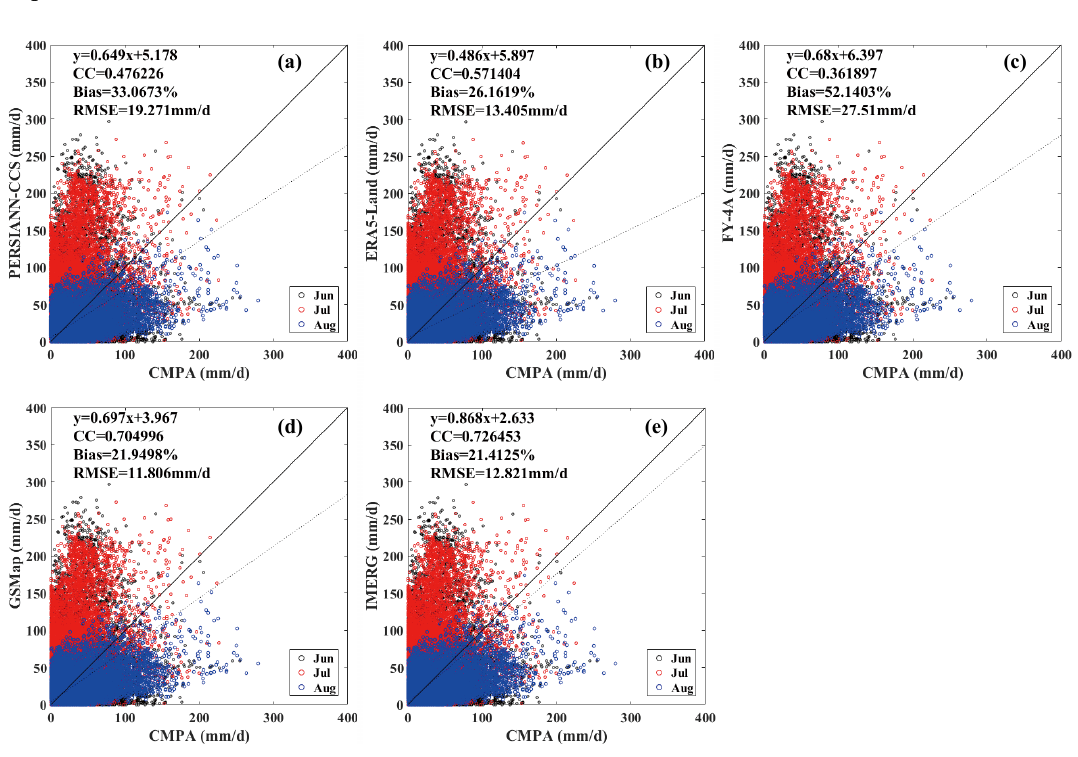
Figure 4. Validations of ( a ) PERSIANN-CCS, ( b ) ERA5-Land, ( c ) FY-4A, ( d ) GSMaP, and ( e ) IMERG at daily scale over southern China in summer